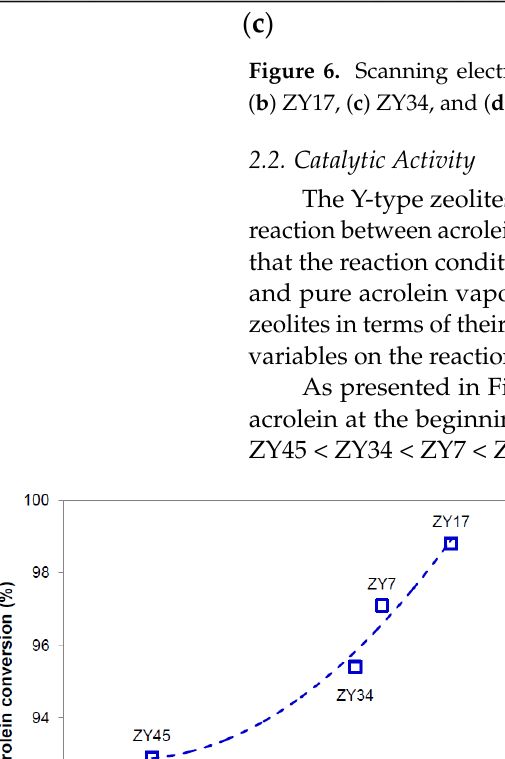
Figure 6. Scanning electron micrographs and particle size distributions of the zeolites ( a ) ZY7, ( b ) ZY17, ( c ) ZY34, and ( d ) ZY45.